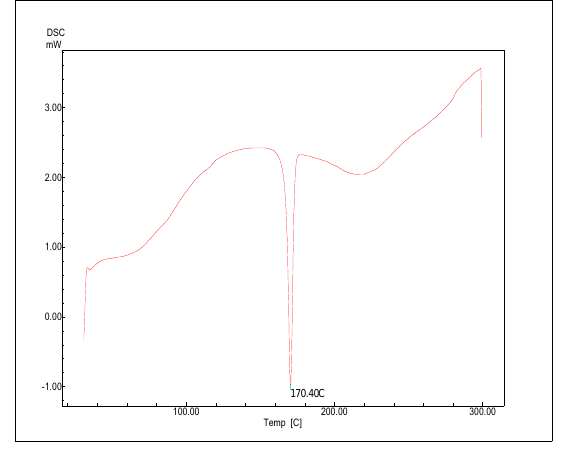
Figure 6. DSC thermogram of sumatriptan optimum core tablet Fourier Transform Infrared Spectroscopy (FTIR): FTIR spectrum of pure sumatriptan drug and the selected core tablet are shown in figures 7 and 8